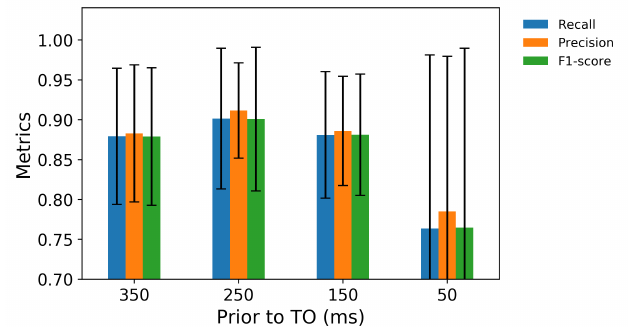
Figure 10. The precision, recall, and F1-score for predictions of transitions from ramp descent 350, 250, 150, and 50ms prior to